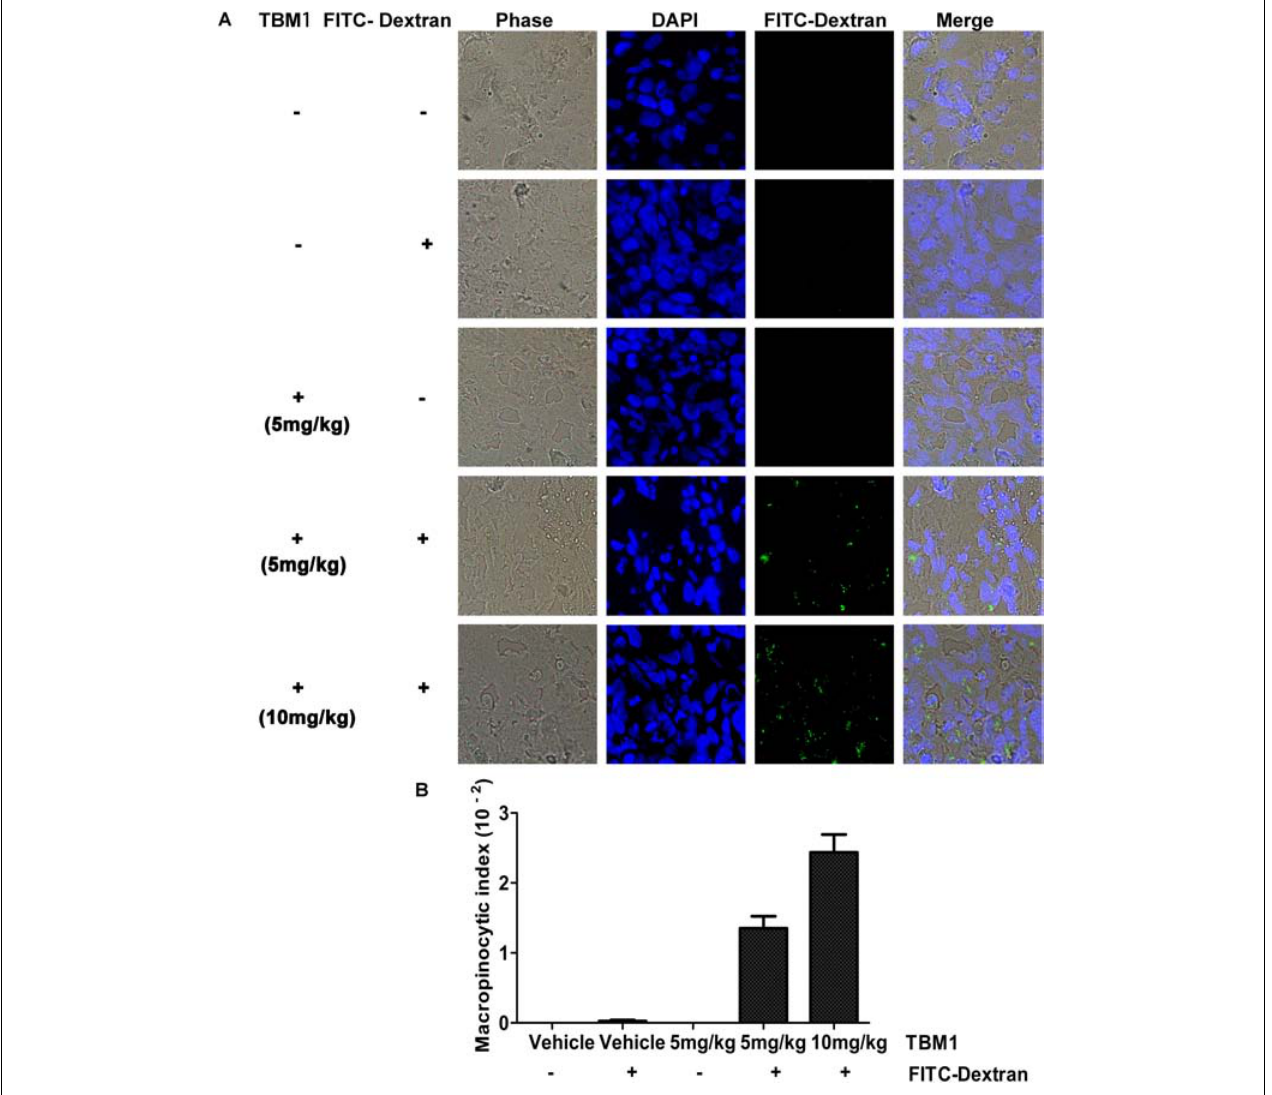
FIGURE 3 | TBM1 induces engulfment of extracellular fluid into tumor tissue in vivo with FITC-Dextran labeling. (A) Tumors from five groups were dissected, fixed, embedded and sectioned. Nuclei are stained with DAPI. Fluorescent images exhibited that FITC-dextran was incorporated into cytoplasmic vacuoles in vivo in mice treated induced-TBM1. Photos were taken by fluorescence microscope (400 × ). (B) Macropinocytic index was calculated as: total particle area / total cell area. Total particle area and total cell area were measured by ImageJ software.